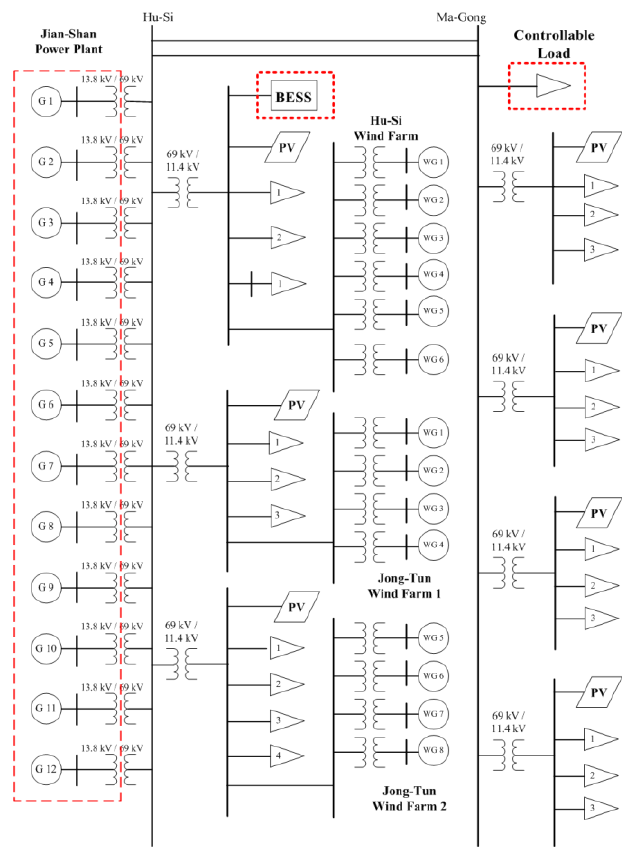
Figure 10. The single line diagram of the power system in Penghu Island.